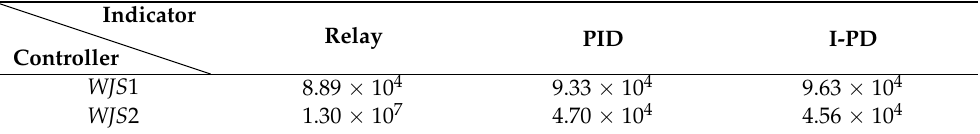
Table 1. Integral values of the control quality indicators in optimal conditions.